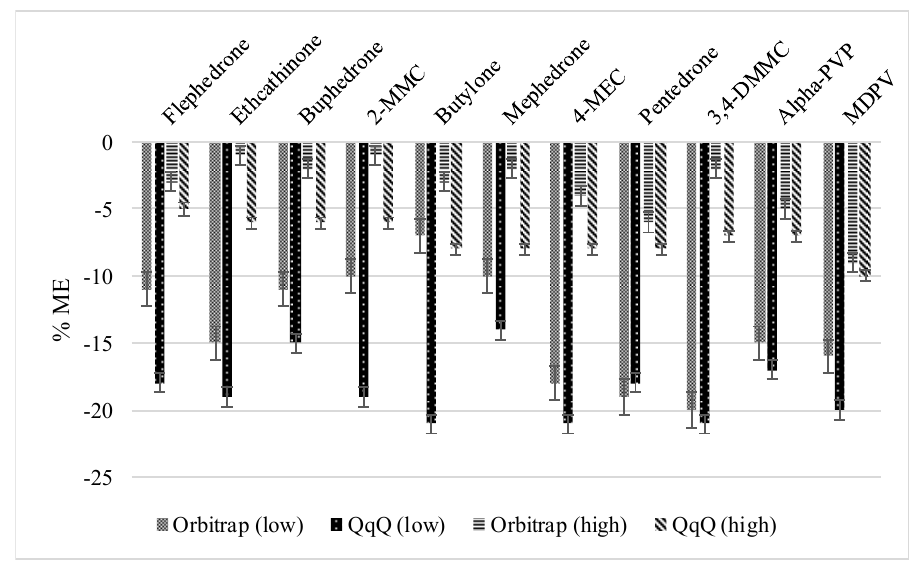
Figure 4. The %ME at low (1 ng g − 1 ) and high (40 ng g − 1 ) levels of concentrations for Orbitrap and QqQ in the analysis of synthetic cathinones in OF. Table 4. Linearity in ng of cathinones, MDLs, and MQLs in ng g − 1 for Orbitrap and QqQ for the determination of synthetic cathinones in OF .